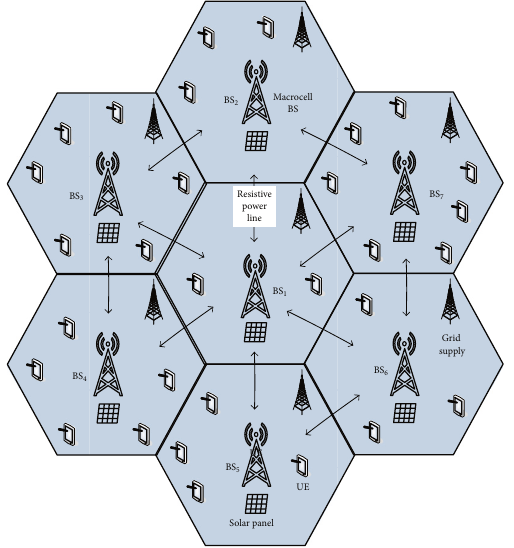
Figure 1: A section of the proposed network model with a hybrid energy supply.